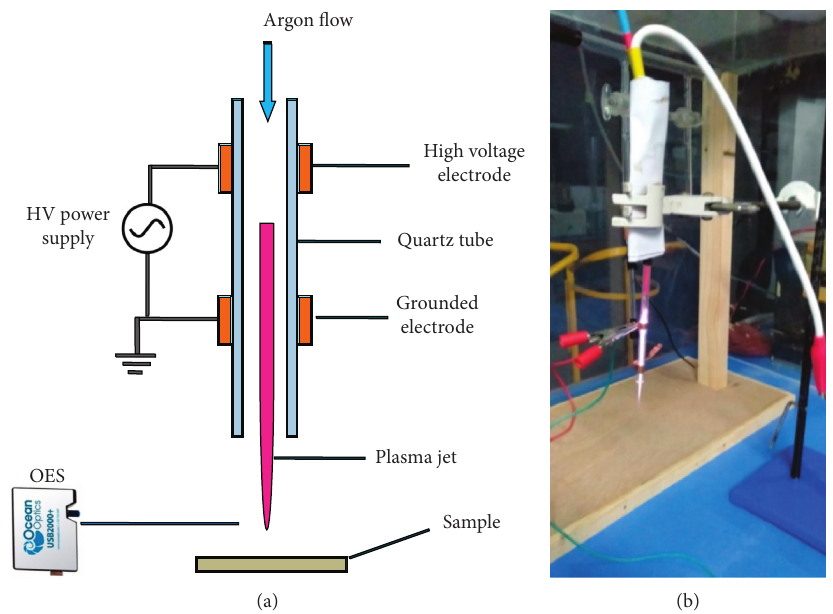
Figure 1: (a) Schematic diagram of the experimental setup and (b) image of the discharge.